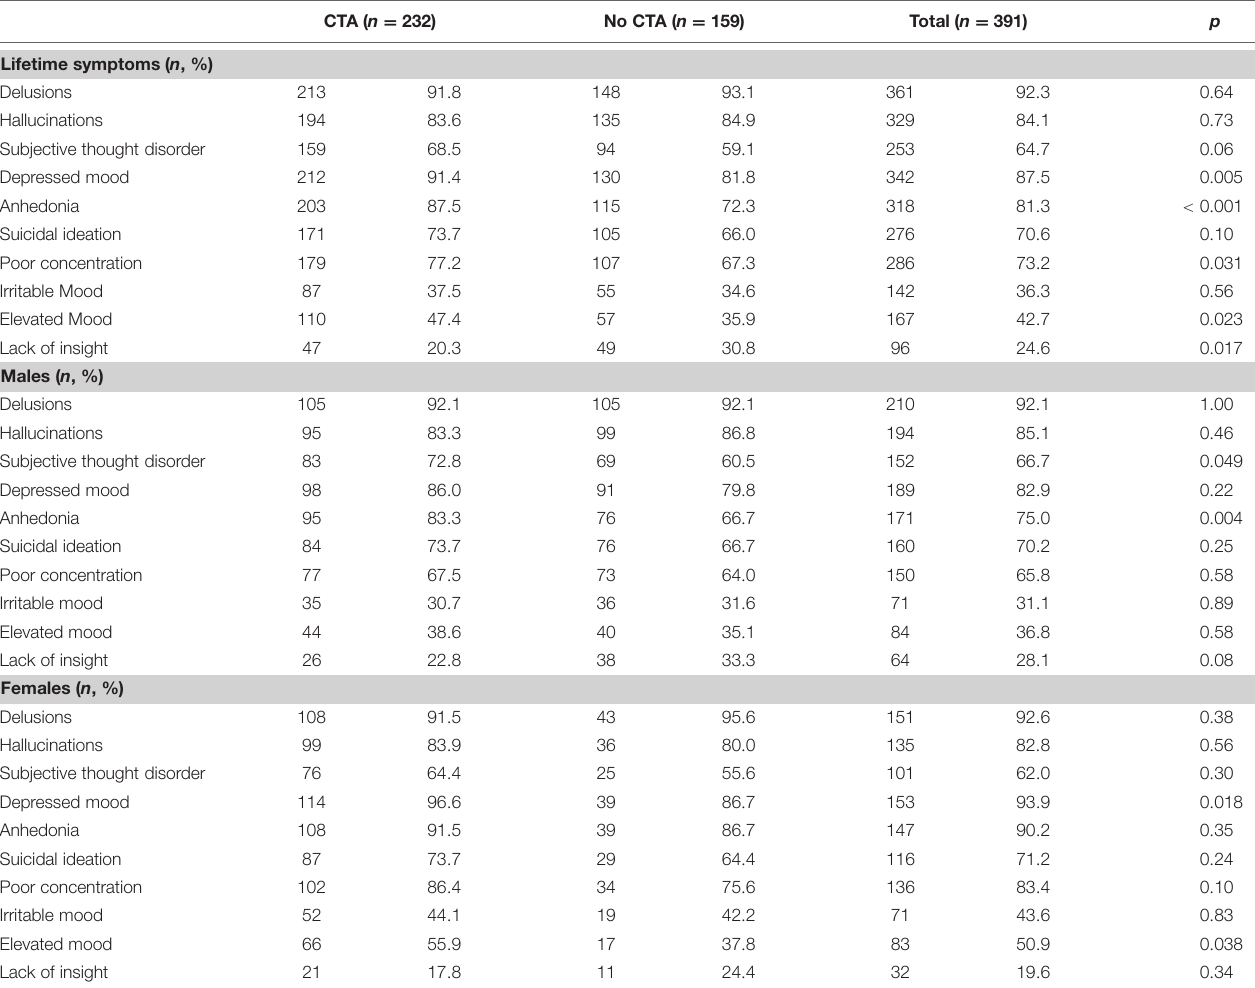
TABLE 3 | Psychological symptoms: lifetime. CTA ( n = 232) No CTA ( n =